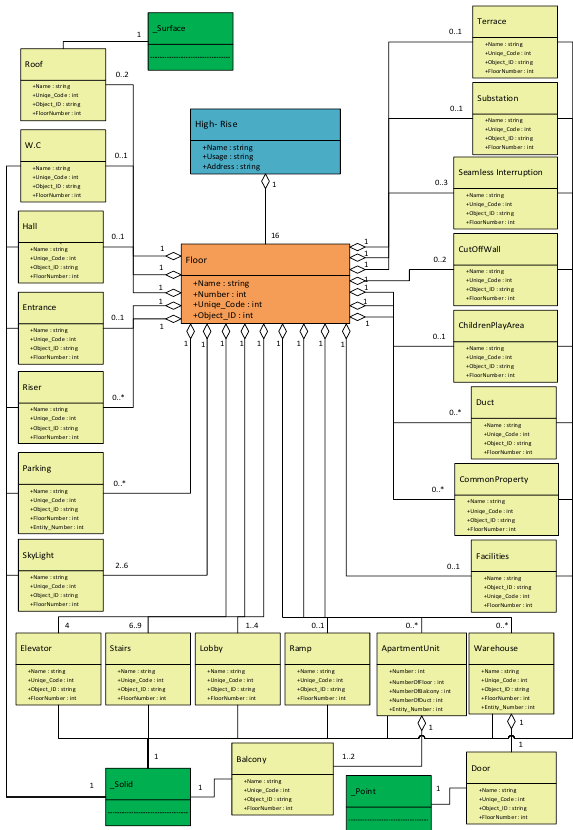
Figure 1. UML Class of Building